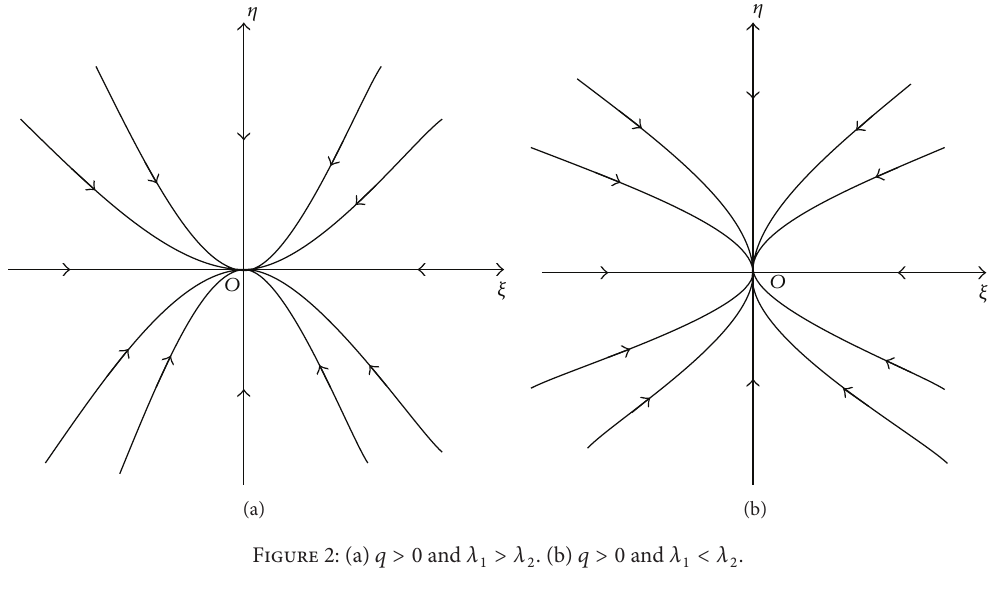
Figure 2: (a) 𝑞 > 0 and 𝜆 1 > 𝜆 2 . (b) 𝑞 > 0 and 𝜆 1 < 𝜆 2